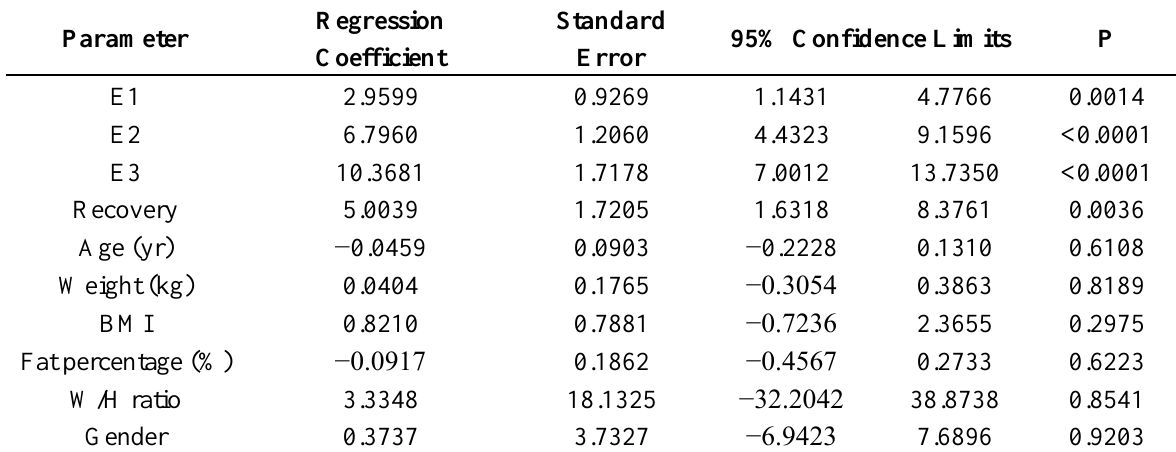
Table 3. Analysis of